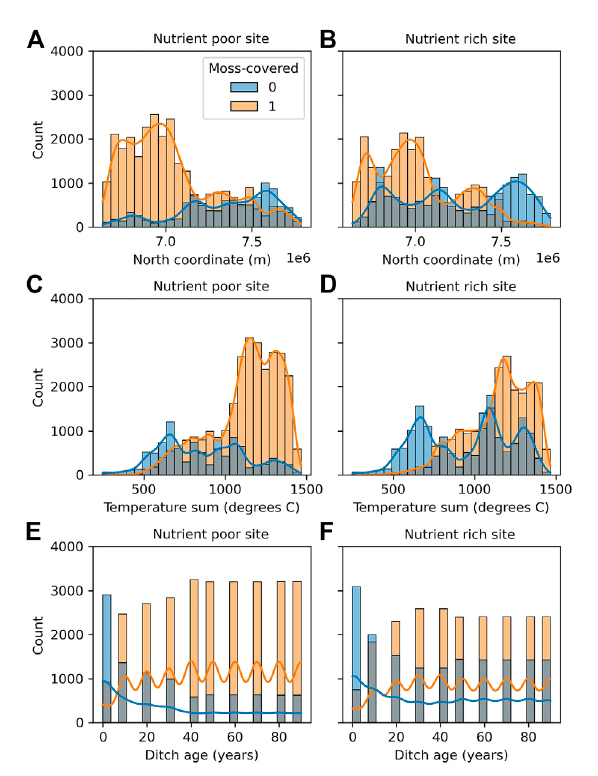
FIGURE 4 Demonstration of classi fi cation model RF25 results using regular point grid (10 km spacing within whole Finland, resulting in 3,829 grid points) and varying ditch age(0,10,...,90years)separately for nutrient poor (A,C,E) and nutrient rich sites (B,D,F) . In total, there were 76,580 points to classify. Note that the distributions demonstrate model performance within the 76,580 points, and thus the fi gures do not represent the real distributions of moss-coverage in Finland since the geographical distribution of ditches and their parameters are different in reality. Note also that the grey bars in the fi gure represent the areas where the orange and blue bars for moss-covered and moss-free ditches overlap.